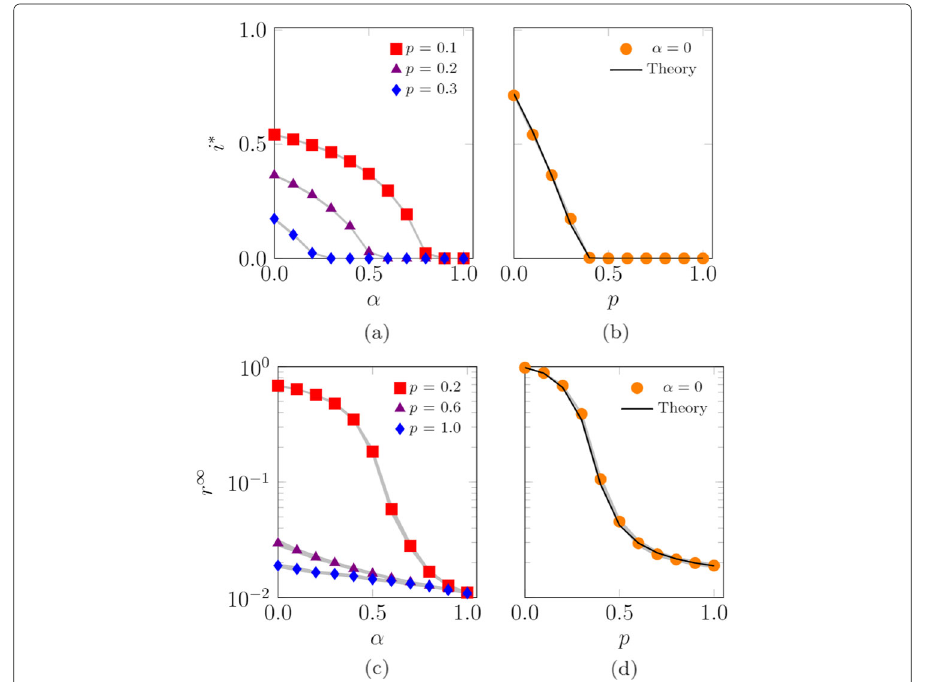
Fig. 6 Influence of the agents’ randomness, α , and probability of jumping outside the location, p , on the SIS endemic prevalence, a - b , and SIR epidemic size, c - d . Theoretical values of the SIS endemic prevalence, b , and SIR epidemic size, d , are computed by evaluating the steady state in Eqs. (13) and (16), respectively. Curves represent the median of 100 independent simulations; 95% confidence bands are displayed in gray. Agents are initially inside their base location and the infection starts after 100 steps to allow the agents to reach a steady-state configuration. The fraction of randomly chosen initial infected agents is 0.01. Other parameter values are L = 1, N = 10,000, D = 100,000, r = 0.0004, c = 0.3333, λ = 0.1, and μ = 0.1